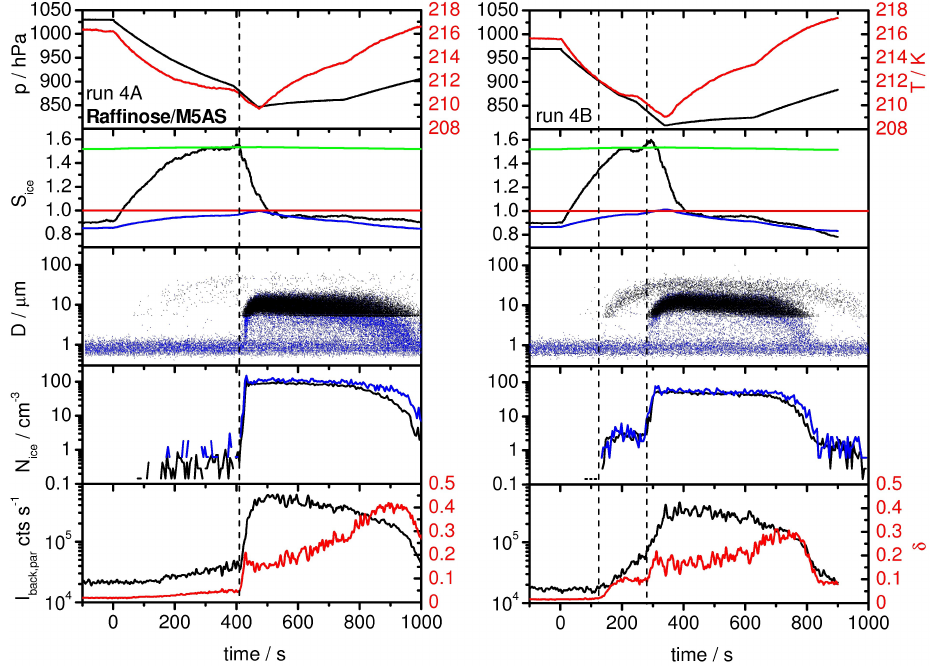
Fig. 12. Time series of various AIDA records during expansion runs 4A and 4B with raffinose/M5AS aerosol particles. The individual panels contain the same measurements as in Fig.